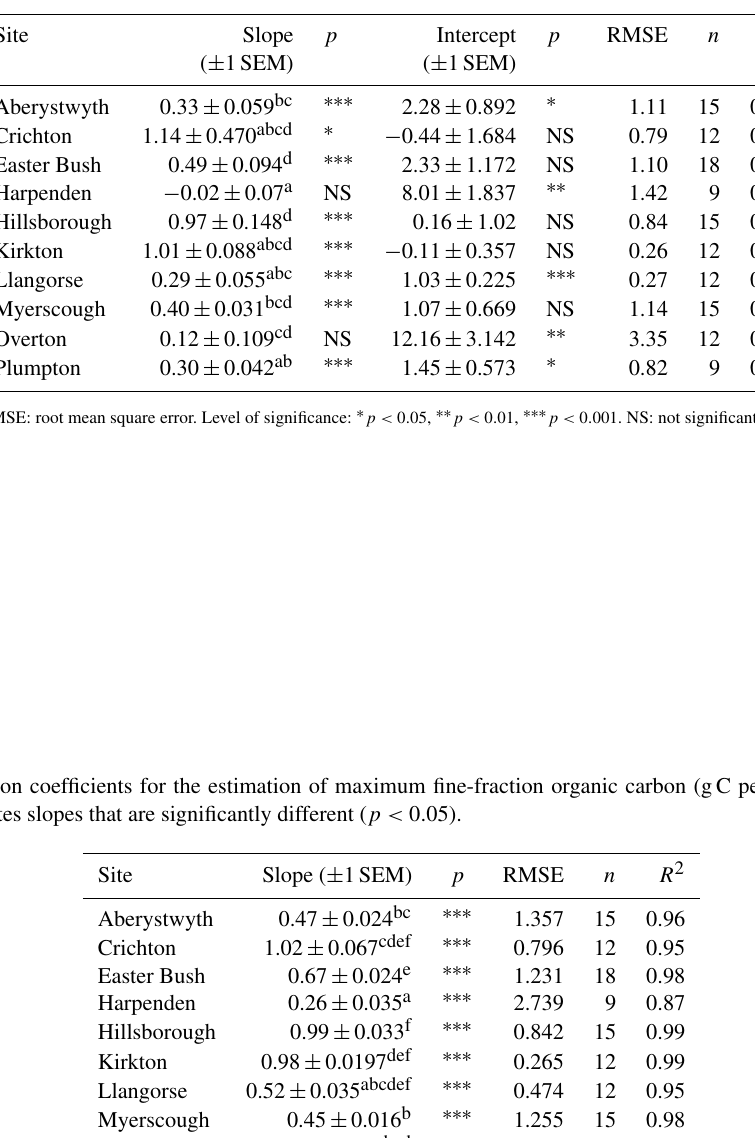
Table A3. Linear regression coefficients for the estimation of maximum fine-fraction organic carbon (gC per kg soil). Lettering indicates slopes that are significantly different ( p < 0 . 05).